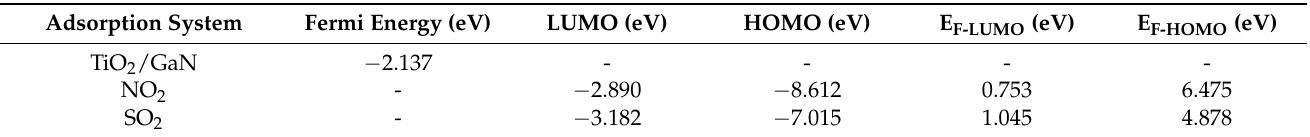
Table 1. Fermi energy, molecular frontier orbital energies, and energy differences. E F-LUMO is the absolute value calculated by E F (device)-E LUMO (gas). E F-HOMO is the absolute value calculated by E F (device)-E HOMO (gas). Adsorption System